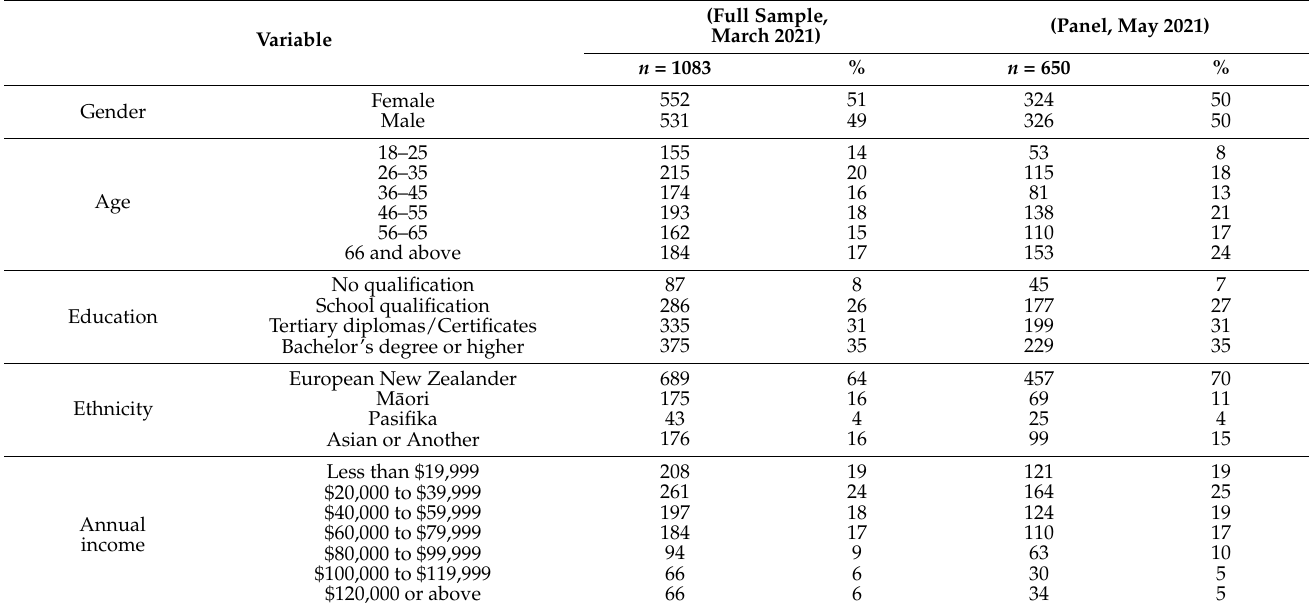
Table 1. Demographic characteristics of the longitudinal